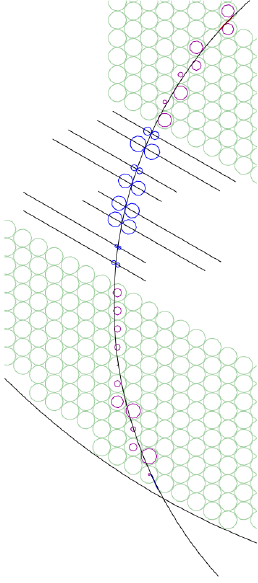
Figure 4: A sketch of a track traversing the STT in the X-Y projection. The skewed straw tubes are rep- resented by black lines. Af- ter the aligning procedure, each of them has two pos- sible isochrone